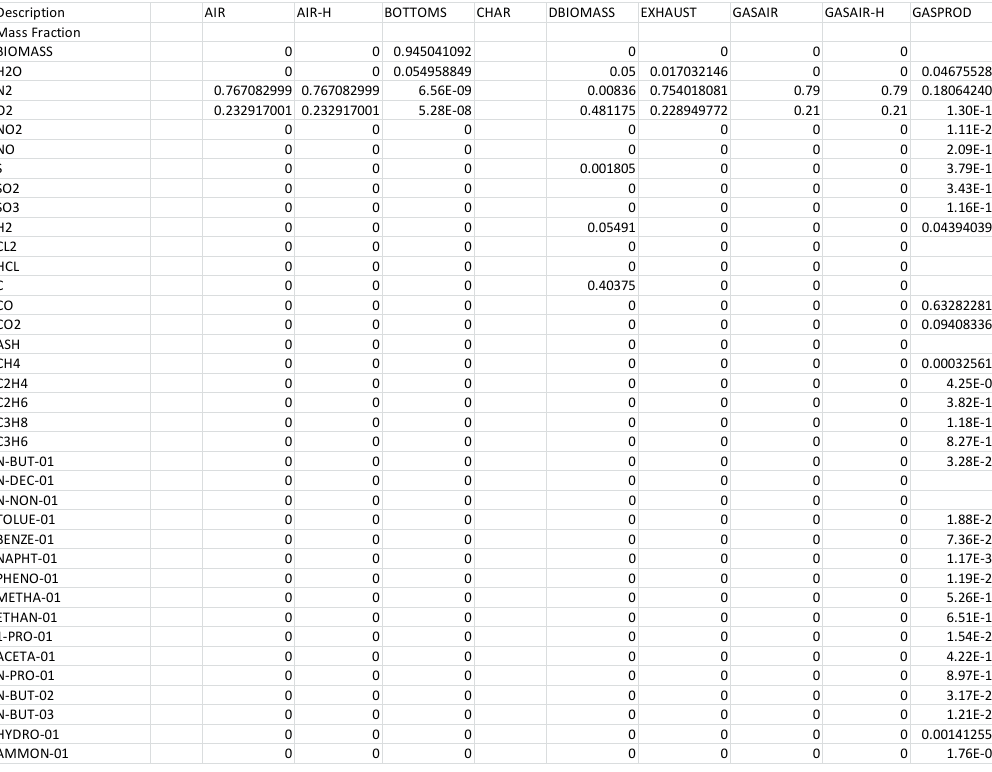
Figure A7. Gasification stream results (part 1—mass fractions).